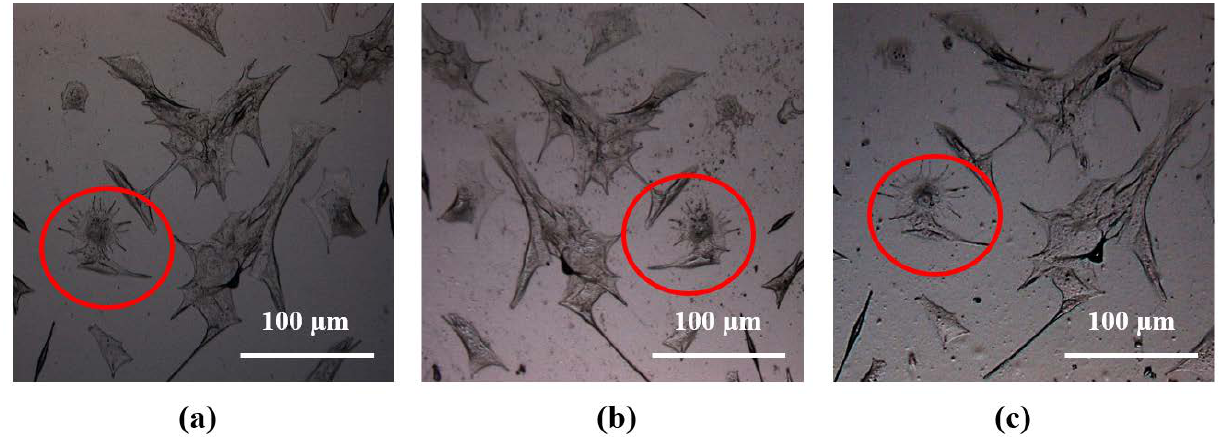
Figure 6. Optical images of ( a ) fixed C2C12 cells on glass, ( b ) negative replica in PDMS, and ( c ) positive replica in conductive hydrogel after plasma and PVP treatment of PDMS. The red circles highlight a unique cell that was used in all the AFM images represented in the next figure.